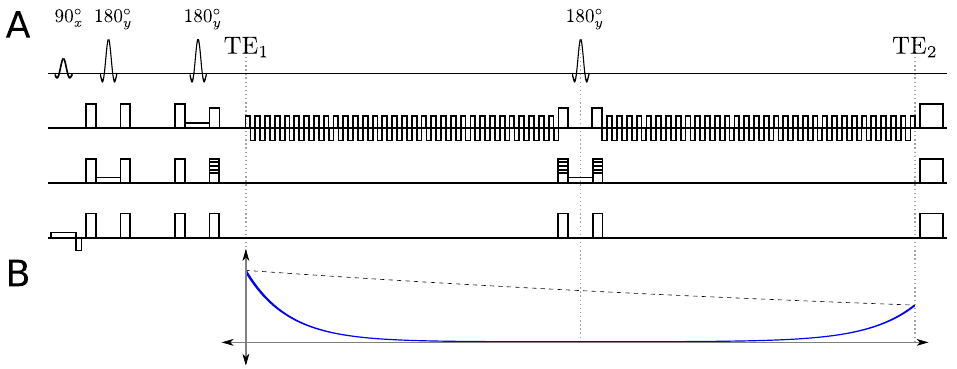
selective 180 ◦ pulse; ( B ) Diagram showing the effect of both T line) decay on the overall shape of the signal